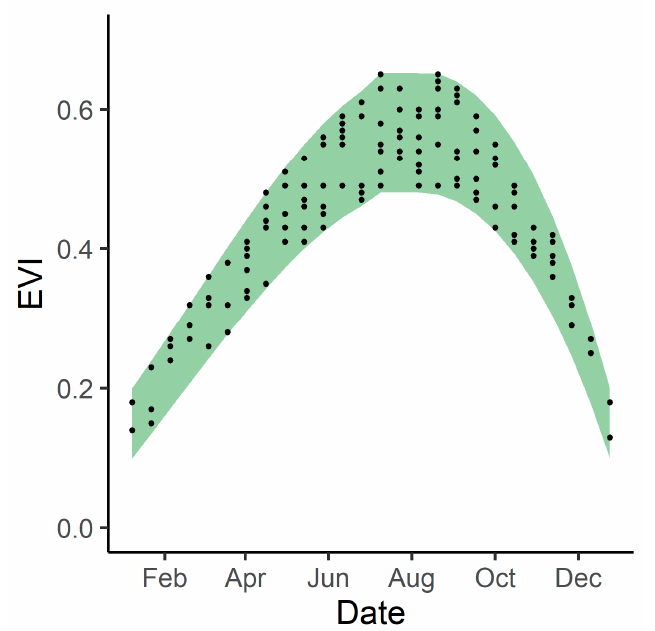
Figure 2. Example of a phenological envelope (curve). The green shaded area represents the upper and lower bounds of expected EVI values, while the points indicate historical EVI values.